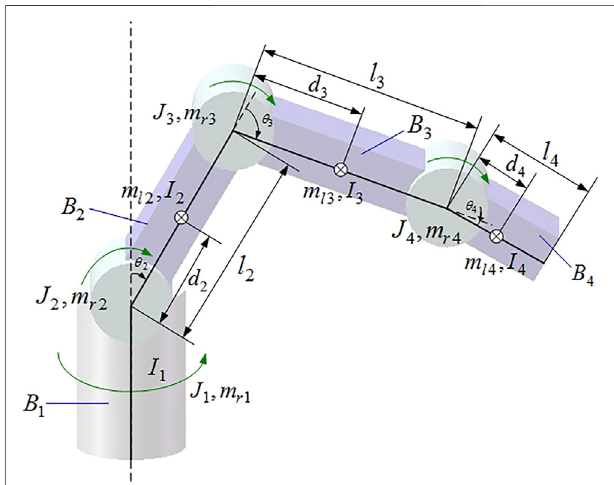
FIGURE 2 | Simpli fi ed model of the